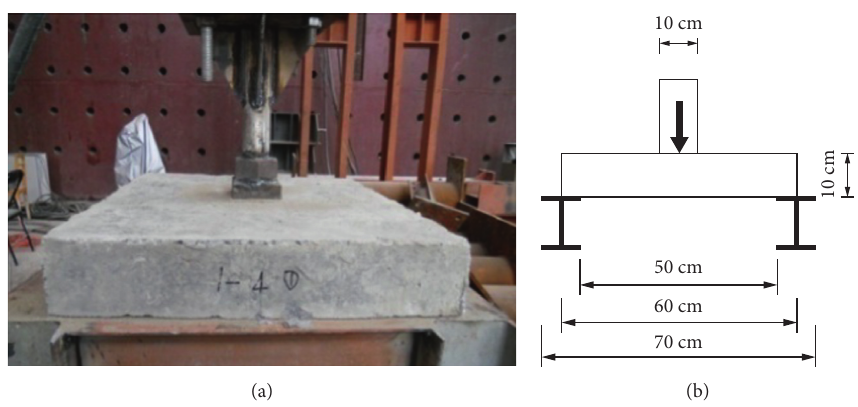
Figure 2: Energy toughness test of large plate. (a) Test photograph. (b) Test diagram.